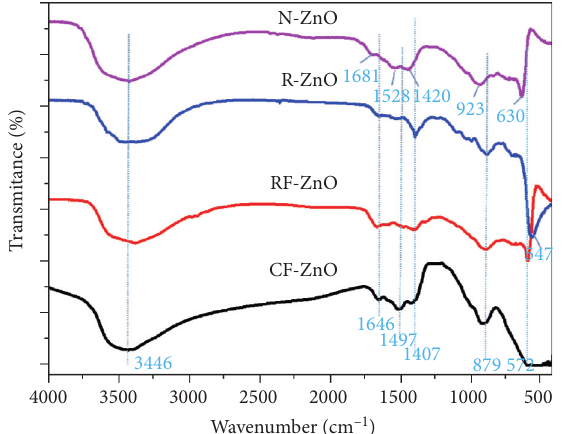
Figure 4: FT-IR spectra of the as-prepared ZnO